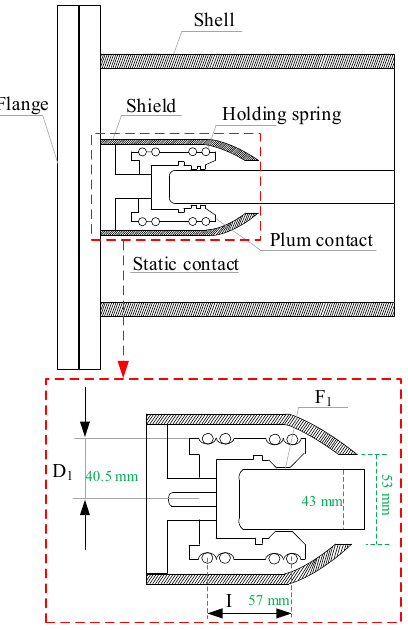
Figure 1. Structure and design parameters of the tulip contact.